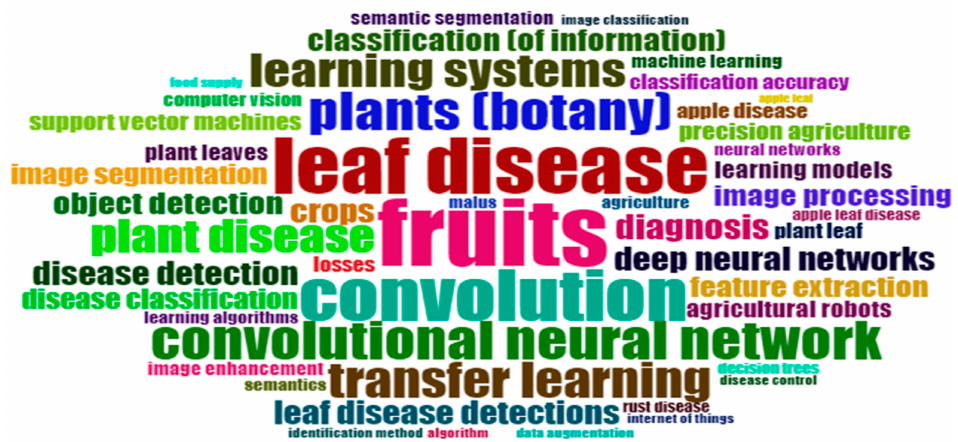
Figure 20. WordCloud of Apple Leaves Disease, DL/ML Keywords (Source: Author elaboration using